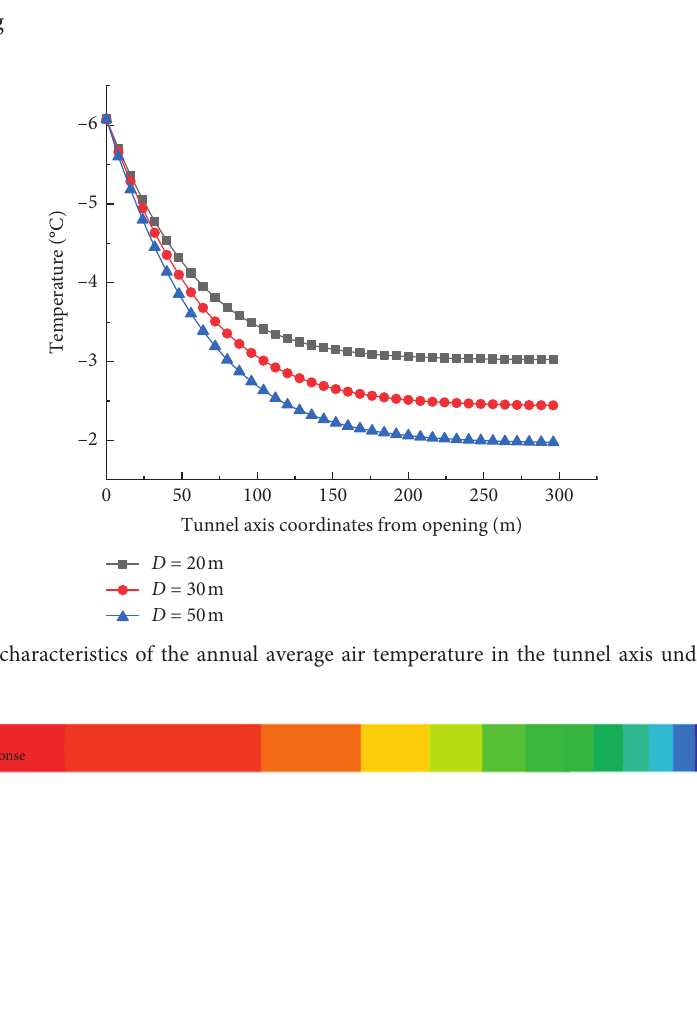
Figure 29: Annual average air temperature distribution in the tunnel axis at an air velocity of 2.5m/s.